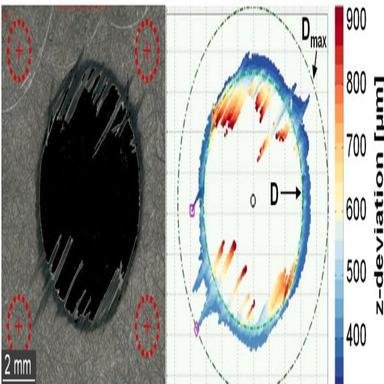
Bore hole and analysis from 3-D- microscope results as the basis for calculating the individual factors for Qd.